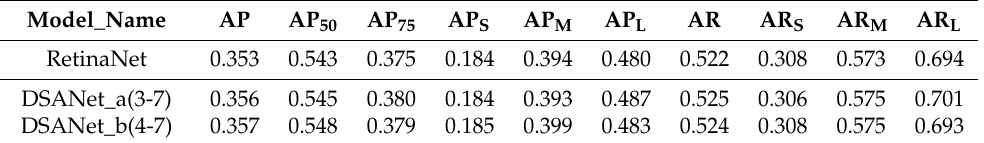
Table 1. Comparison of DSA modules using different attention methods. DSANet_a uses the attention method shown in Figure 3a, while DSANet_b uses the attention method shown in Figure 3b; “3-7” or “4-7” shows that we add a DSA module in FPN conv3-7 or conv4-7 fusion features. As the computation of self-attention is too large, it is out of GPU memory when using self-attention in conv3 feature map with higher resolution. Hence, DSANet only adds self-attention DSA module in conv4-7 FPN fusion features, and other experiments abide by the same